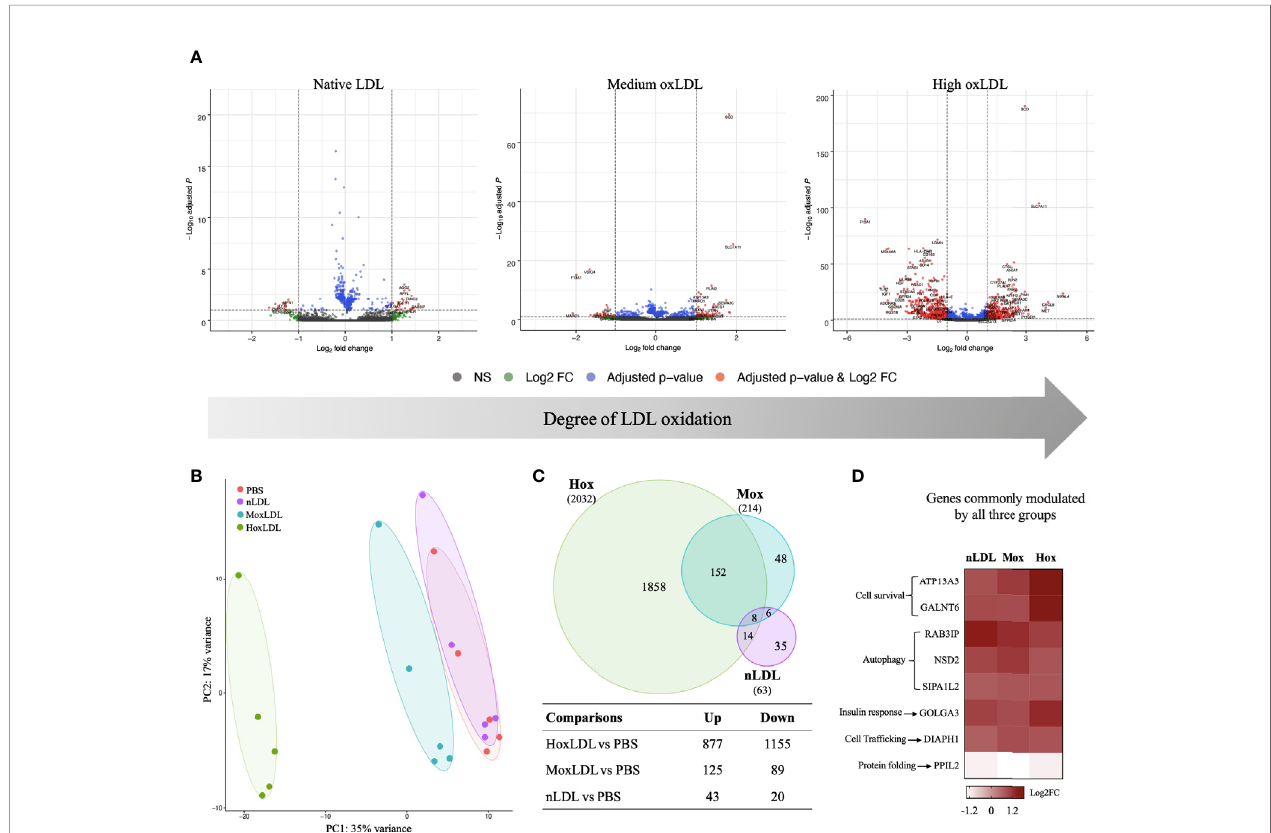
FIGURE 1 | The degree of cholesterol oxidation drives transcriptomic changes in human M2-like macrophages. (A) The volcano plots display the changes in the M2-like macrophages gene expression after 24 hours of LDL-stimulation compared to cells stimulated by PBS (n=5) . Three types of LDL were used: non-oxidized (native), medium oxidized (MoxLDL), and highly oxidized (HoxLDL). The transcriptomic changes increase according to the degree of LDL oxidation. (B) The principal component analysis con fi rms the signi fi cance of transcriptomic changes induced by LDL oxidation. Ellipses indicate the con fi dence interval of groups. Axis percentages indicate variance contribution. (C) The Venn Diagram shows the overlapping genes in each group. Only 8 genes are commonly induced by LDL regardless of the oxidation degree, while 152 genes are stimulated due to LDL oxidation. The table shows the amount of upregulated and downregulated genes in the groups. (D) The common genes expressed due to LDL exposure are all upregulated and are related to cell survival, endoplasmic reticulum stability, response to insulin, and